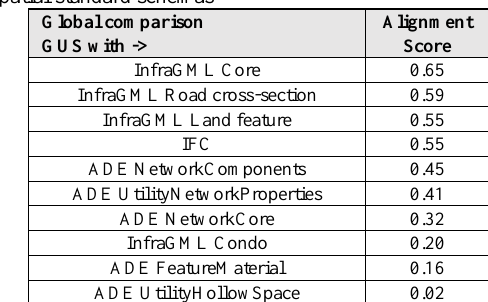
Table 1. Overall comparison of global user schema (GUS)